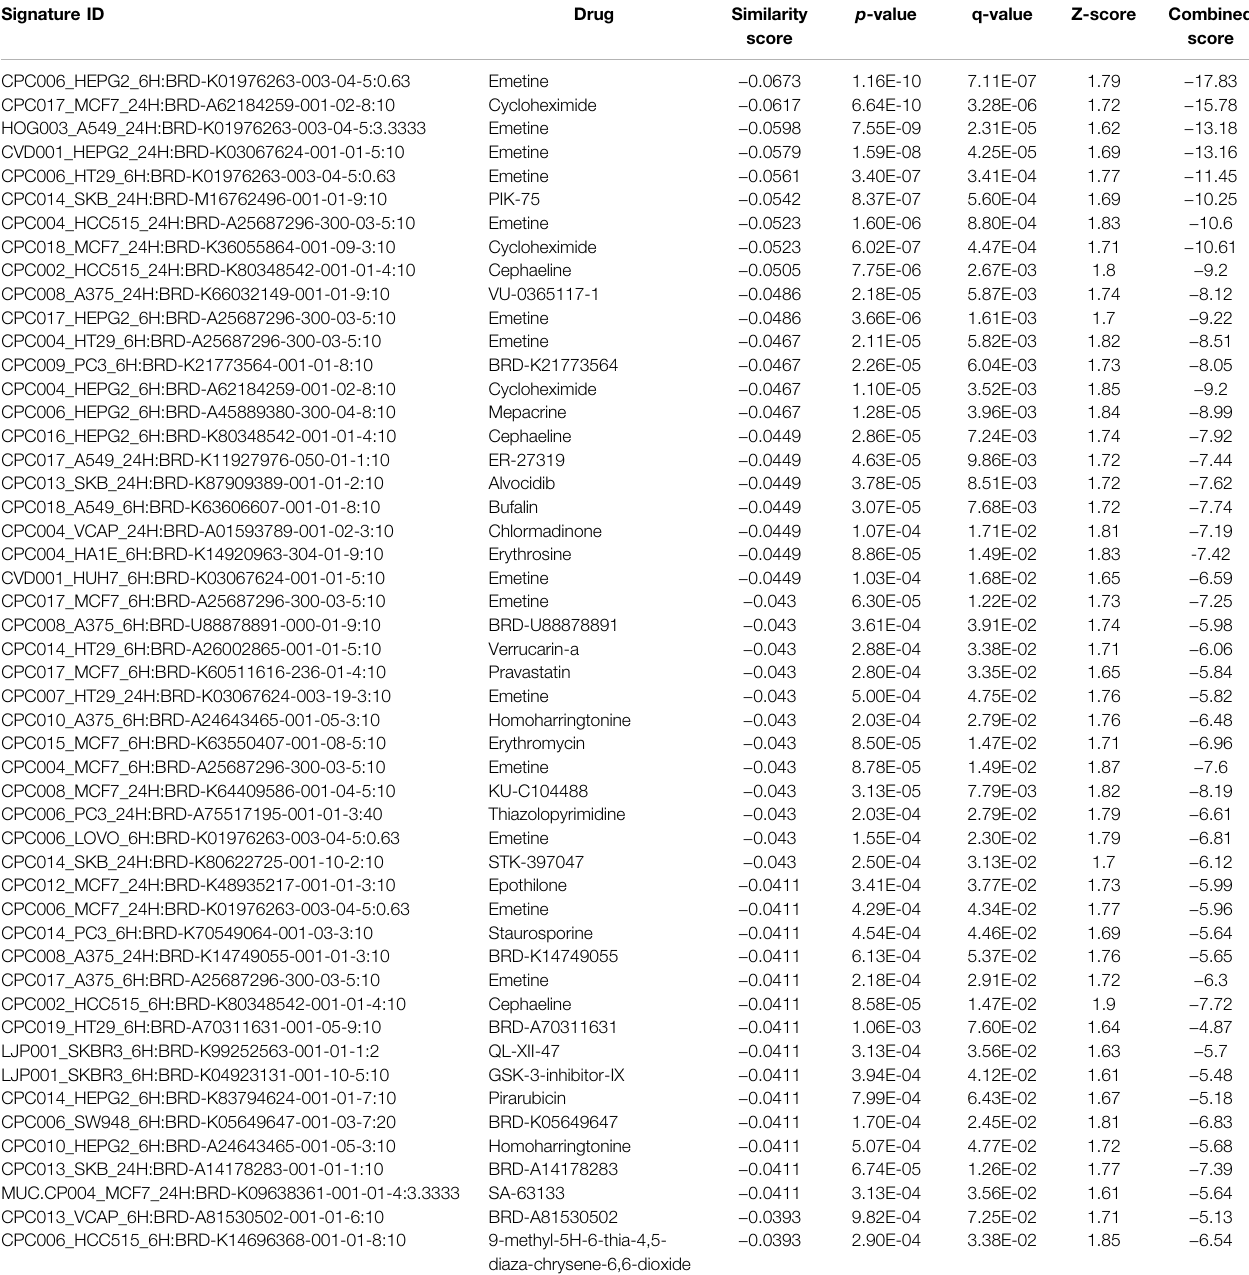
TABLE8| Thetop50drugsornaturalproductsthatreverseDEGsofastrocytesfromentorhinalcortexinAD(AD00203(disease)vsAD00201(control)basedonL1000FWD